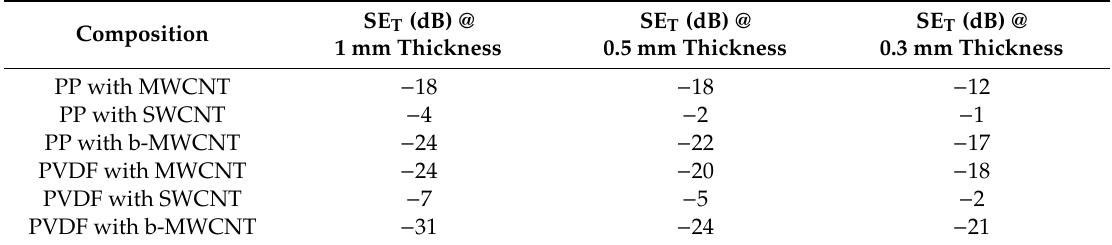
Table 1. Shielding e ff ectiveness (SE T ,@ 18 GHz) of various composites with thickness variation.